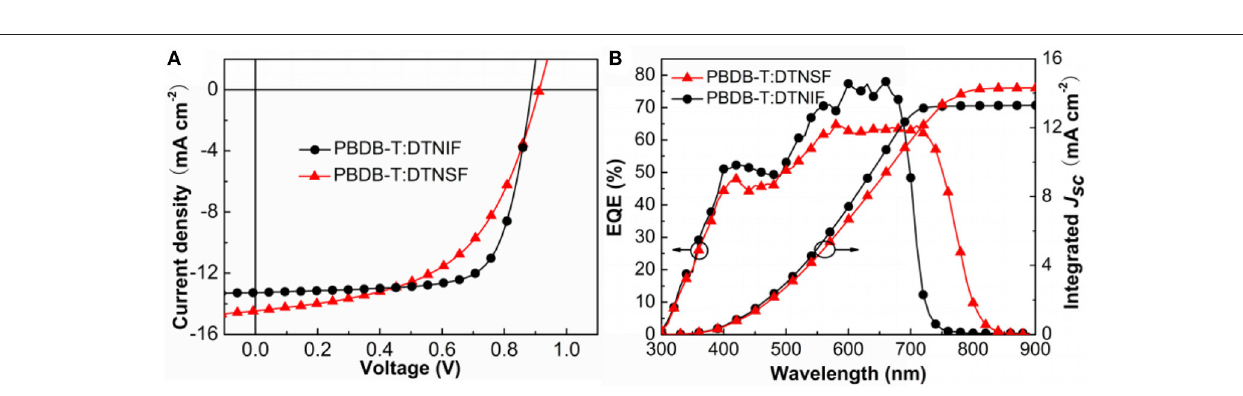
respectively. The integrated values are in consistent with those from the J-V measurement within 2%